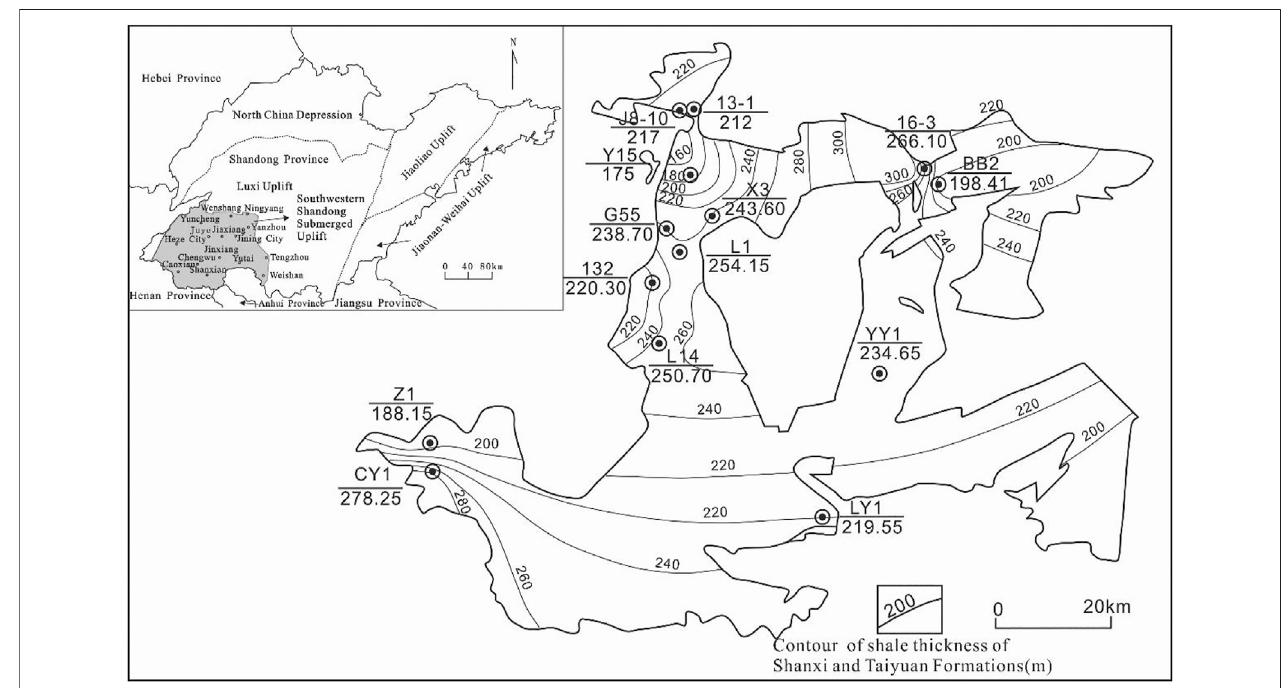
FIGURE 1 | Contour map of the shale thicknesses of Shanxi and Taiyuan